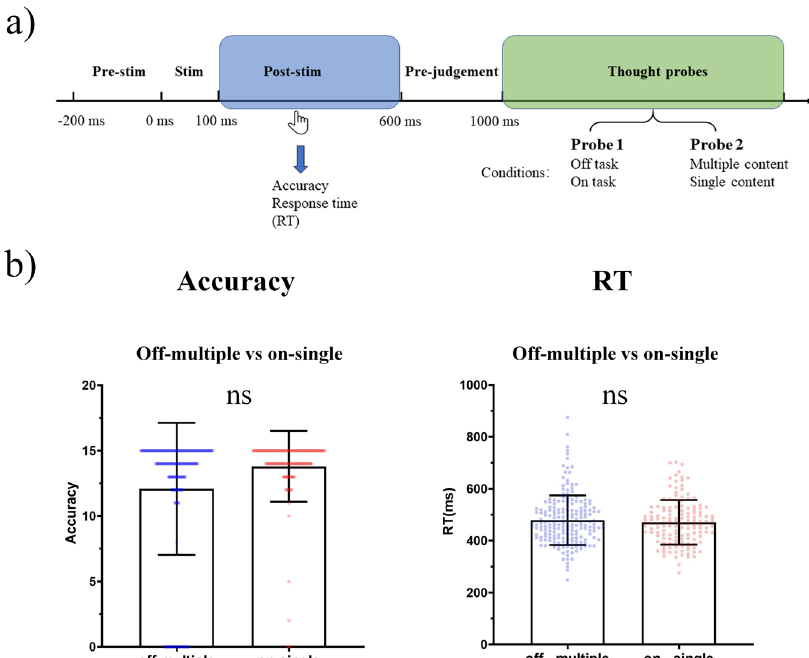
Fig. 2 Behavioral analysis schema and results. a Analysis schema: Data analysis was trial-based across subjects. The accuracy, response time (RT), and probe answers were taken into behavioral analysis. All trials were divided into different conditions according to probe answers: off-thought vs on-thought based on the fi rst probe, multiple-contents vs single-content based on the second probe, off-multiple vs on-single based on the combination of the fi rst as well as second probe. GLMM and LMM were applied on accuracy and RT between conditions respectively. Chi square analysis was applied between two probes. b Results of GLMM and LMM on the accuracy and RT between off-multiple and on-single. There were no signi fi cant differences between off- multiple and on-single on accuracy or RT. The error bar means SD; ns: no signi fi cance.